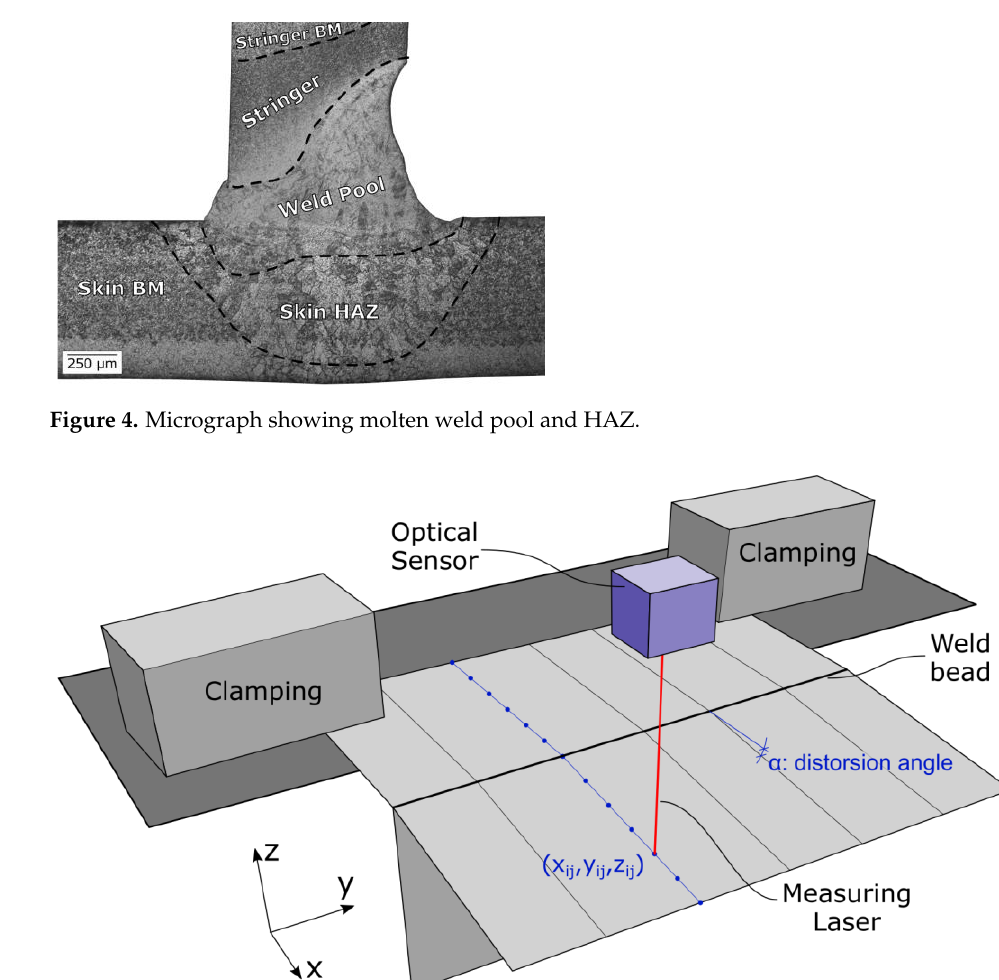
Figure 5. Angular distortions